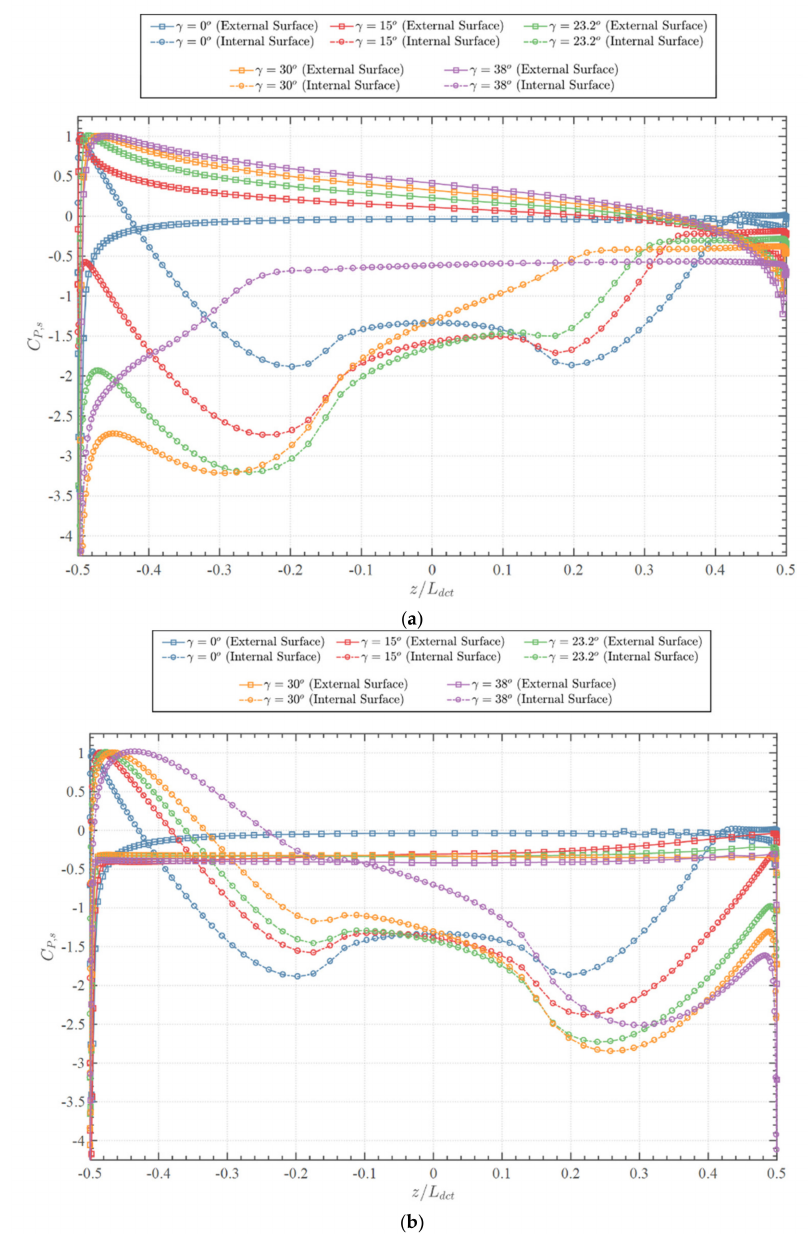
Figure 14. Evaluations of static pressure coefficient ( C P , s ) distribution along the duct surfaces at γ = 0 ◦ , 15 ◦ , 23.2 ◦ , 30 ◦ , 38 ◦ . ( a ) Static pressure coefficient along the duct surfaces at port-side; ( b ) Static pressure coefficient along the duct surfaces at